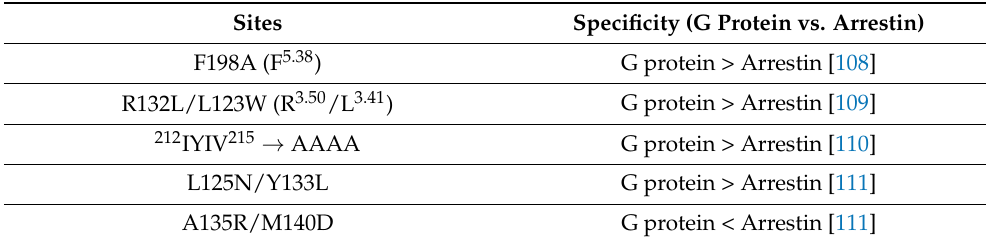
Table 2. Regions involved in the biased signaling of dopamine D 2 receptor. Sites Specificity (G Protein vs.